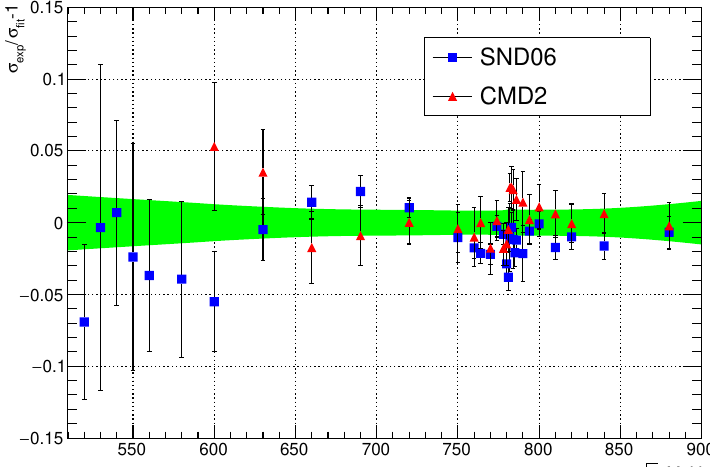
Figure 16 . The relative di(cid:11)erence between the e + e (cid:0) ! (cid:25) + (cid:25) (cid:0) cross sections measured by SND [26] and CMD-2 [28] at VEPP-2M and the (cid:12)t to the SND data at VEPP-2000. The error bars take into account both statistic and systematical errors of VEPP-2M data. The shaded area corresponds to the quadratic sum of the systematic and statistical errors of the SND at